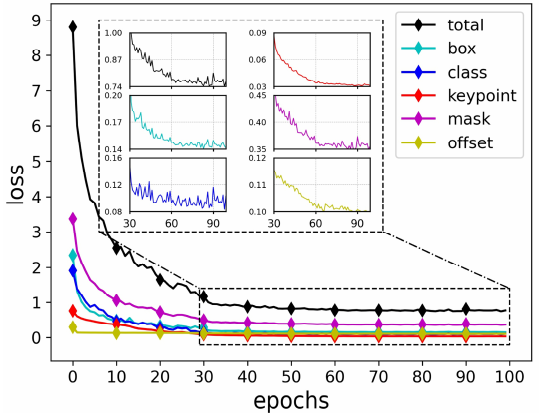
Figure 11. Loss of Key-Yolact.